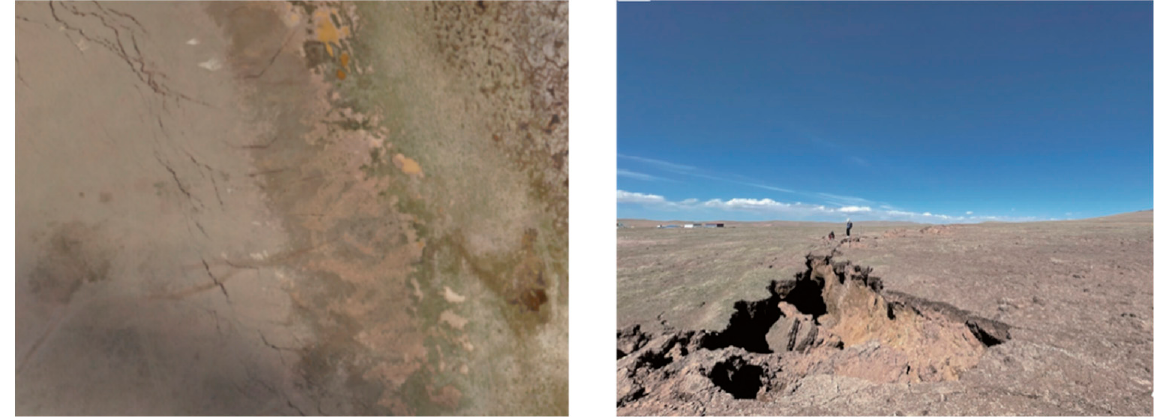
Figure 3. Post-earthquake UAV orthophoto image and field photos.